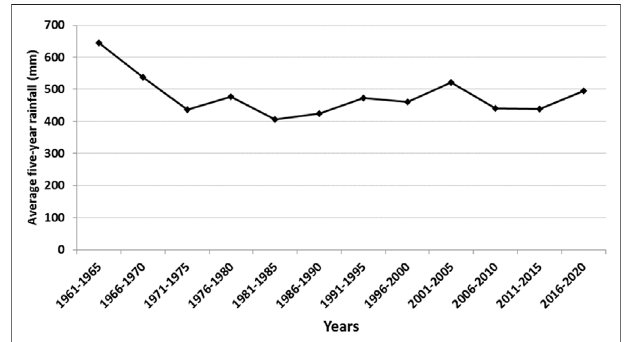
FIGURE 1 | Rainfall evolution from 1961 to 2020 in Seno Province (historical data; from 1961 to 2010 were provided by Direction Générale de la Météorologie; those from 2011 to 2020 were from Essakane Pulsonic meteorological station, Burkina